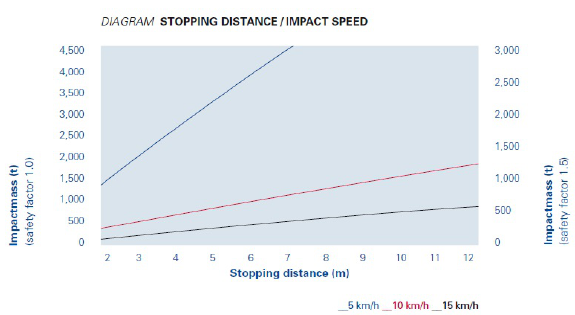
Figure 5. RAWIE 16 ZEB, stopping distance/impact speed/impactmass diagram, safety coefficient 1,0 and 1,5